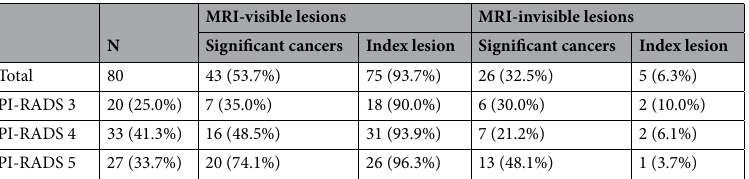
Table 2. Index lesions and significant prostate cancers in MRI-visible and MRI-invisible lesions. MRI magnetic resonance imaging; PI-RADS Prostate Imaging–Reporting and Data System.